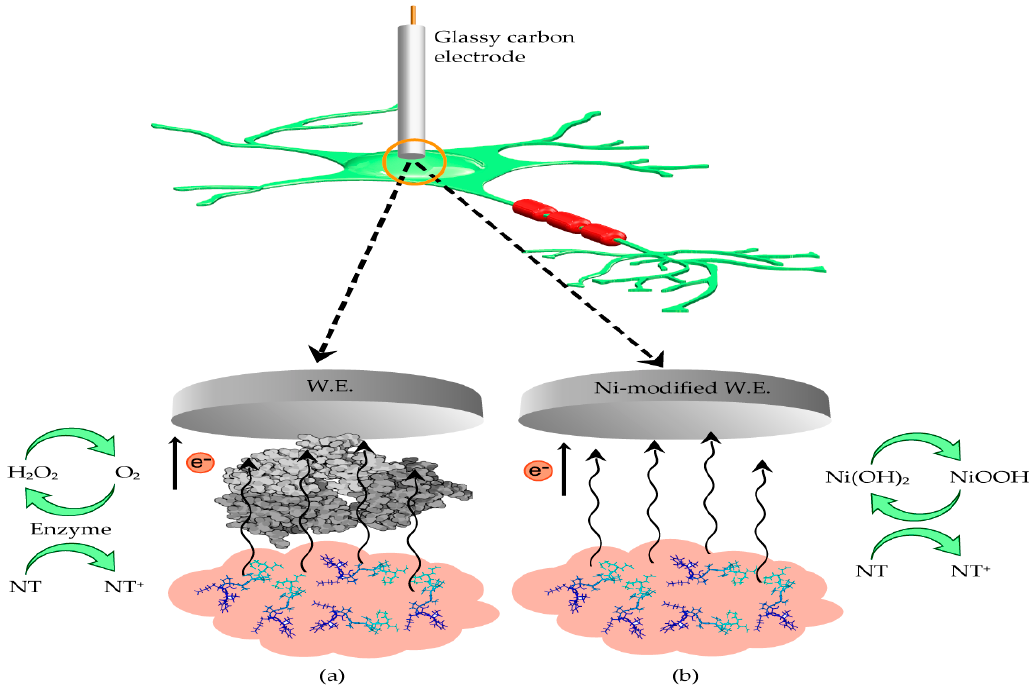
Figure 1. Schematic of neurotransmitter detection methods at working electrode (WE) surface: ( a ) enzymatic sensing; ( b ) Non-enzymatic sensing using a nickel-based material as an example.